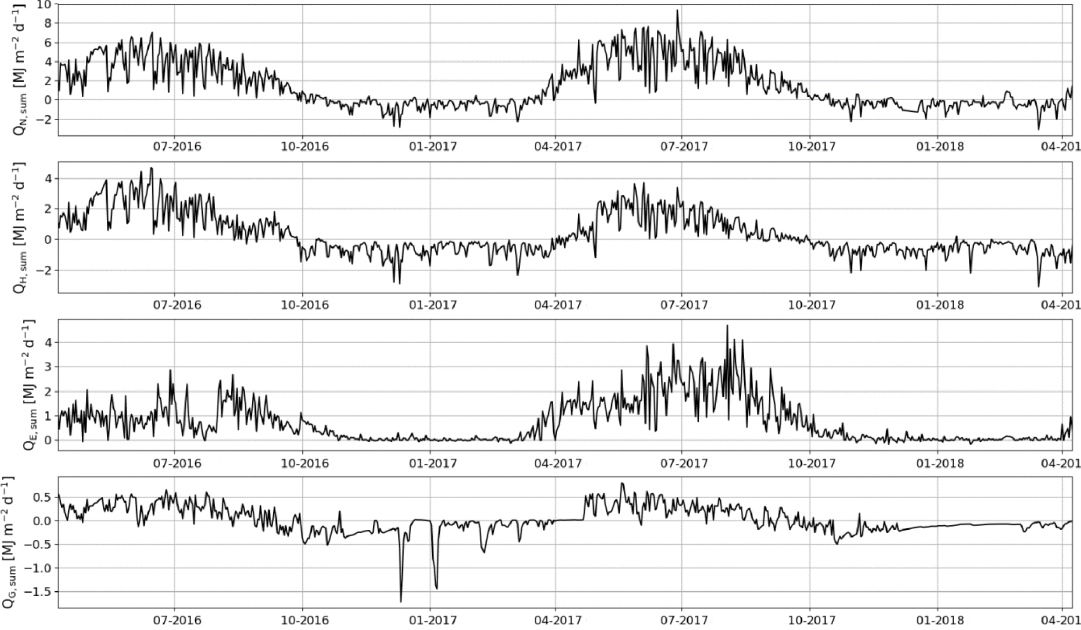
Figure 11. Daily sums of net radiation ( Q N ), sensible heat flux ( Q H ), latent heat flux ( Q E ) and ground heat flux ( Q G ).